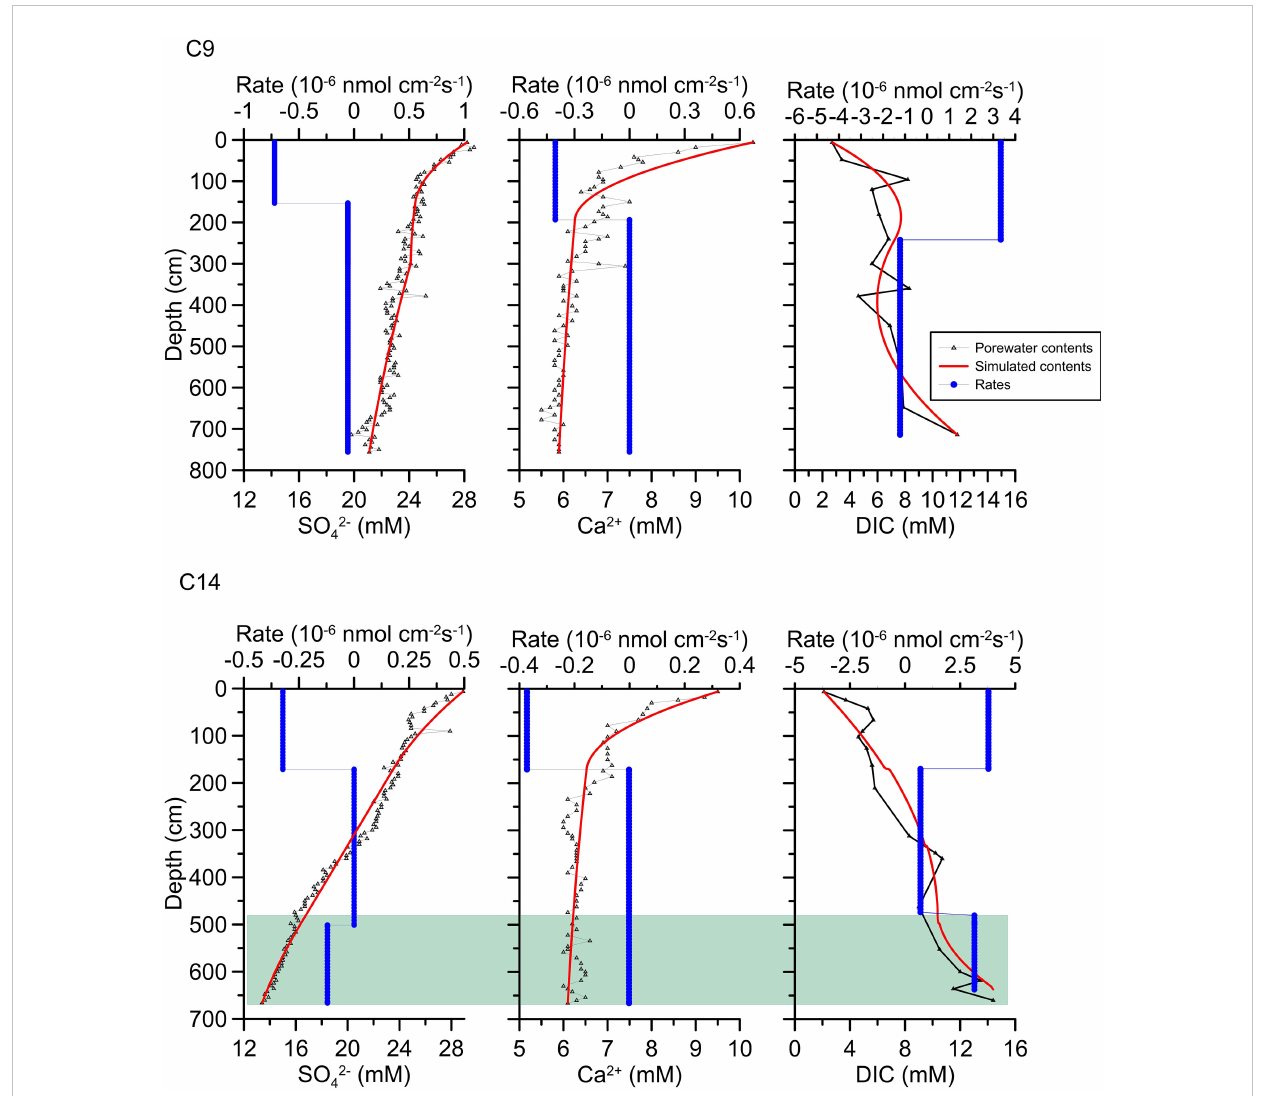
FIGURE 2 Depth pro fi les of pore water geochemical data for C9 and C14 sites. Black triangle with line indicates the measured concentration, red line represents the simulated concentration based on PROFILE model, and the blue line represents the net (production or consumption) reaction rate. Green shadow indicates the sulfate-methane transition